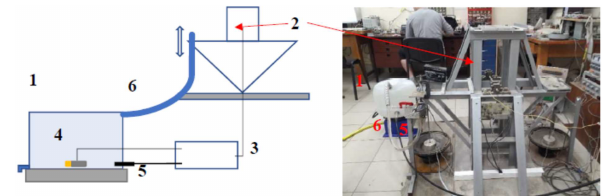
Figure 7. Principal design and view of the MET hydrophone cal- ibration set. 1 – container with water and hydrophones; 2 – verti- cal offset generator; 3 – DA converter/digitizer; 4 – the MET hy- drophone; 5 – piezoelectric hydrophone BC-311; 6 – open-end pipe with water.